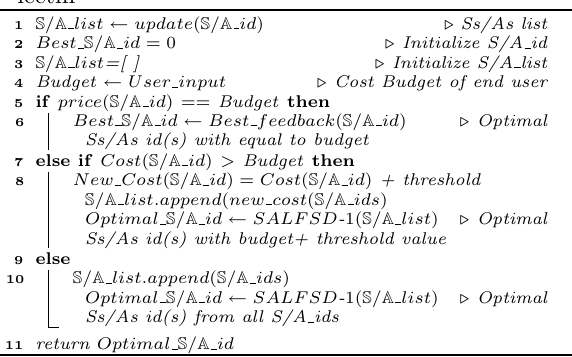
Algorithm 2: SALFSD -2 Optimaization